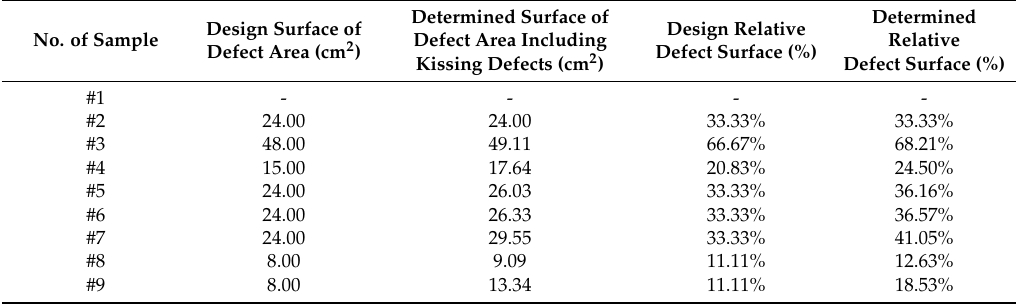
Table 1. Designed and determined area of